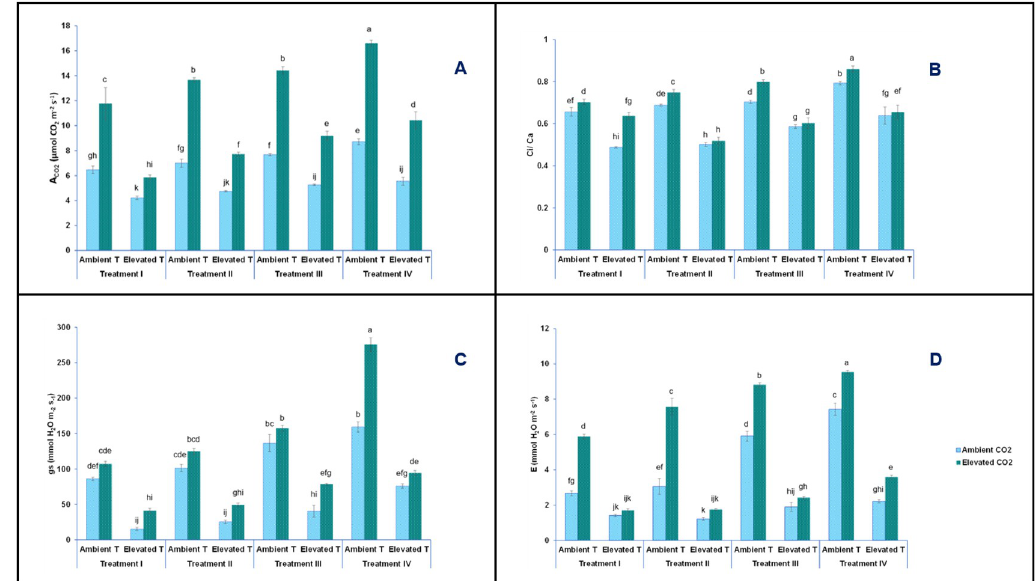
Fig 2. Effect of the short-term heat stress on net photosynthetic rate (A CO2 ) (A), intercellular/external CO 2 concentration ratio (Ci/Ca) (B), stomatal conductance (g S ) (C) and evapotranspiration (E) (D) in leaves of baby-leaf lettuce cv Derbi at two levels of CO 2 and four different NO 3- /NH 4+ treatments. Different letters are significantly different according to Tukey’s test at p � 0.05.